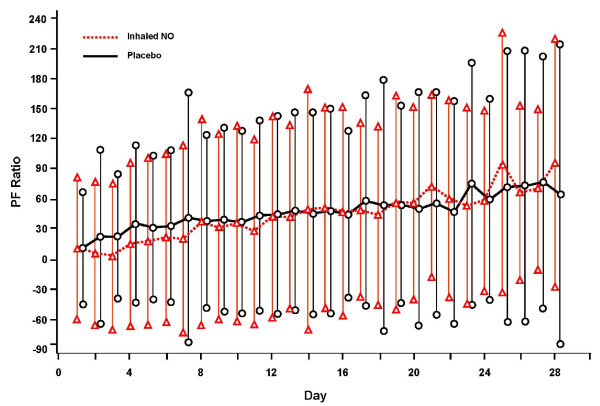
Aggregate of individual subject data of daily change (mean ± SD) from baseline parameter for P/F ratio through day 28. NO, nitric oxide; PF, PaO2/FiO2 ratio.